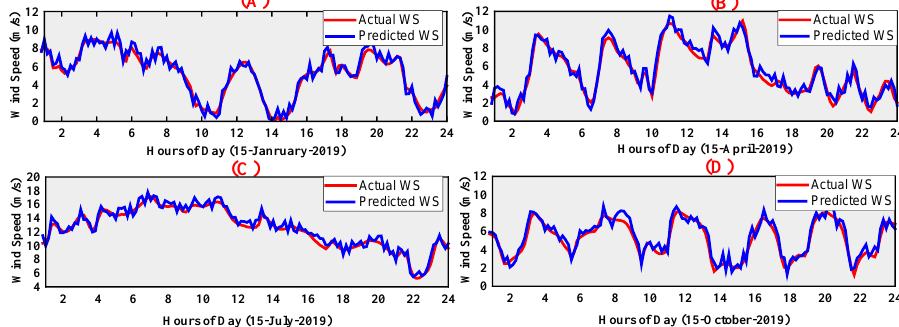
Figure 7. Variation in wind speed for one day during ( A ) winter, ( B ) summer, ( C ) spring, and ( D ) autumn.